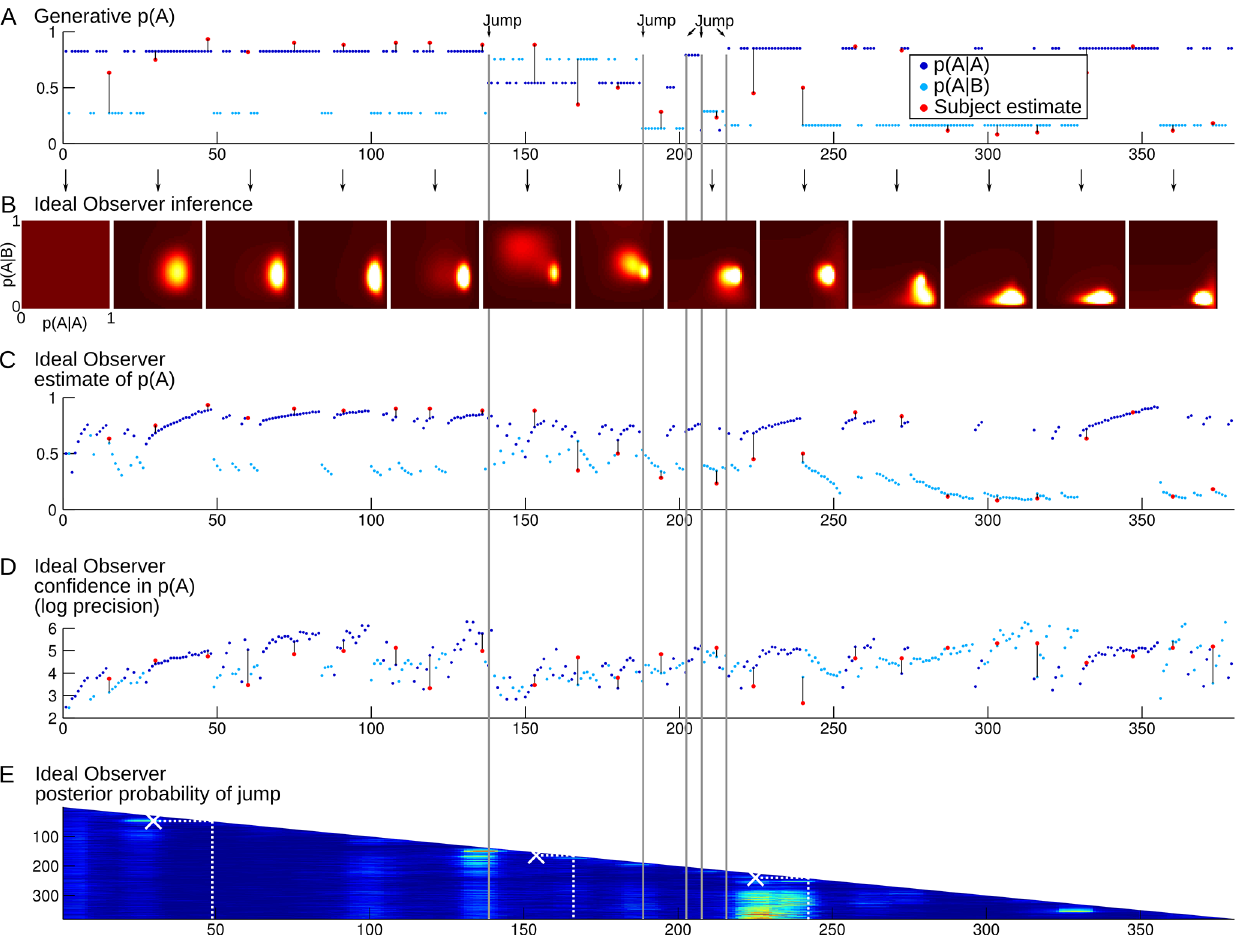
Fig 2. Example of the time course of a full session. (A) Each dot represents a stimulus in the sequence (dark blue = A, light blue = B). The position on the y-axis shows the true generative probability of having the stimulus A at a given trial, which is conditional on the preceding stimulus. The 5 changes in transition probabilities are highlighted in gray. The red dots show the subject's probability estimates that the next stimulus is A (the answer to Question 1 in Fig 1). The black lines facilitate visual comparison between the subject's estimates and the corresponding generative values. (B) Temporal evolution of the distribution of transition probabilities estimated by the Ideal Observer. The distribution is updated at each observation, but it is plotted only every 30 stimuli for illustration purposes. The distribution is two-dimensional: p(A|A) and p(A|B) can be read as marginal distributions along the vertical and horizontal axes. Point estimates and the related confidence levels can be read respectively as the mean and negative log variance. (C) Temporal evolution of Ideal Observer point estimates of the transition probabilities. The transition probabilities estimated by the Ideal Observer sometimes differ substantially from the generative ones, and better account for the subject's estimates, e.g. around stimulus 240. (D) Temporal evolution of the Ideal Observer confidence in the estimated transition probabilities. Confidence levels from the Ideal Observer and the subject cannot be compared directly: subjective reports were made on a qualitative bounded scale (Question 2 in Fig 1) whereas the Ideal Observer confidence in principle is not bounded. For illustration purpose, subjective confidence levels (red dots) were overlaid after adjusting their mean and variance to match those of the Ideal Observer. Several features are noteworthy: drops of confidence levels after suspicion of jumps (e.g. around stimulus 50) and a general trend for confidence to increase with the number of observations within a chunk (e.g. from stimulus 1 to 50). (E) Evolution of the posterior probability that a jump occurred around ( ± 5) each stimulus of the observed sequence, as estimated by the Ideal Observer. Hotter colors denote higher probabilities. This estimation is revised after each new observation. The successive estimations result in the succession of longer and longer rows as more and more stimuli are observed in the sequence. Jumps reported by the subject are overlaid as white crosses. For instance, at stimulus 50, the subject pressed the detection key to report a jump located at stimulus 30. This detection was actually a false alarm with respect to the generative jumps, but the Ideal Observer also estimated that a jump was likely at this